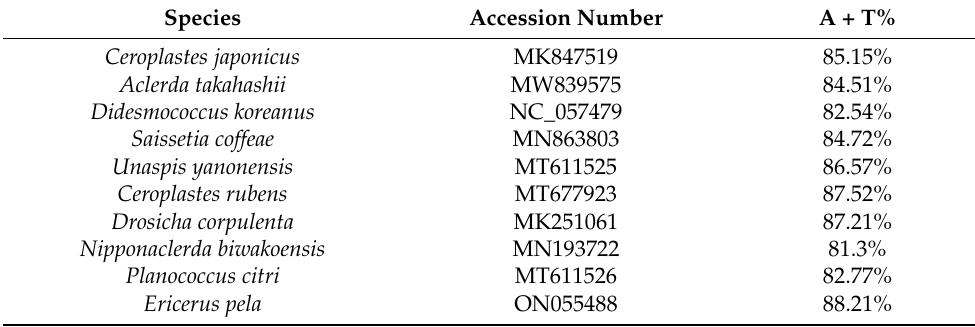
Table 2. The species included in the synteny analysis and their A + T%.